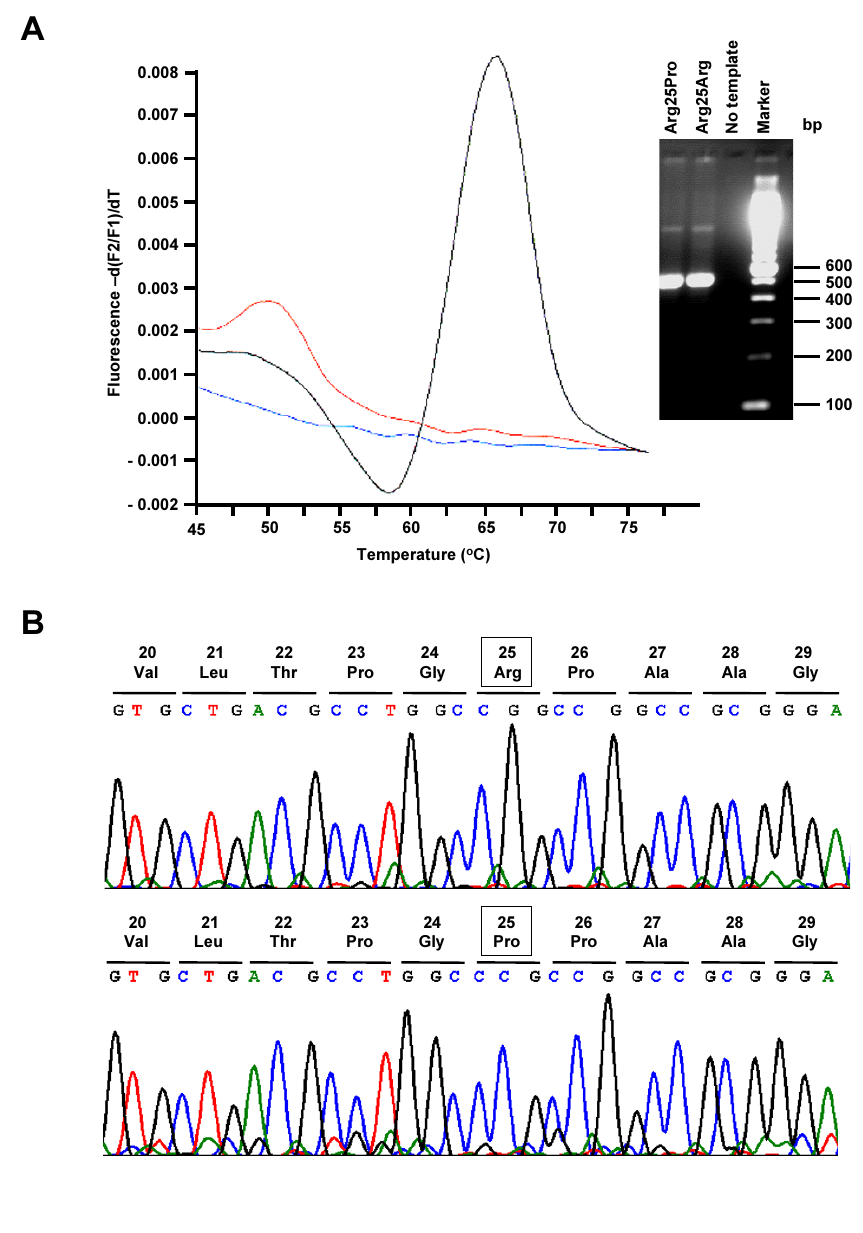
Figure 2 Molecular analysis of the TGF- β 1 allele variations at codon 25: (A) representative derivative melting curves of a rep- resentative LightCycler run for analysis of the Arg25Pro gene polymorphism in the TGF- β 1 gene. Samples shown are: no tem- plate control (blue line) Arg25Arg (red line), Arg25Pro (black line), respectively. The amplified products of this LC run were separated in a 1.5% agrose gel showing the expected amplicon 523-bp in size (inlet). (B) Sequence analysis of the Arg25Pro alleles. 80 ng genomic DNA from a patient having a heterozygous allele constellation was taken as template in standard PCR and amplified using primers Arg25Pro-for and Arg25Pro-rev. Amplified DNA was gel purified, cloned into the pGEM-T Easy vector, and sequenced with primer Arg25Pro-for on the sense strand on the ABI PRISM310 Genetic Analyzer. The upper chromatogram was derived from the Arg25-allele, the lower chromatogram from the Pro25-allele. Amino acids Arg25 or Pro25 encoded by the polymorphic site (CGG or CCG) are